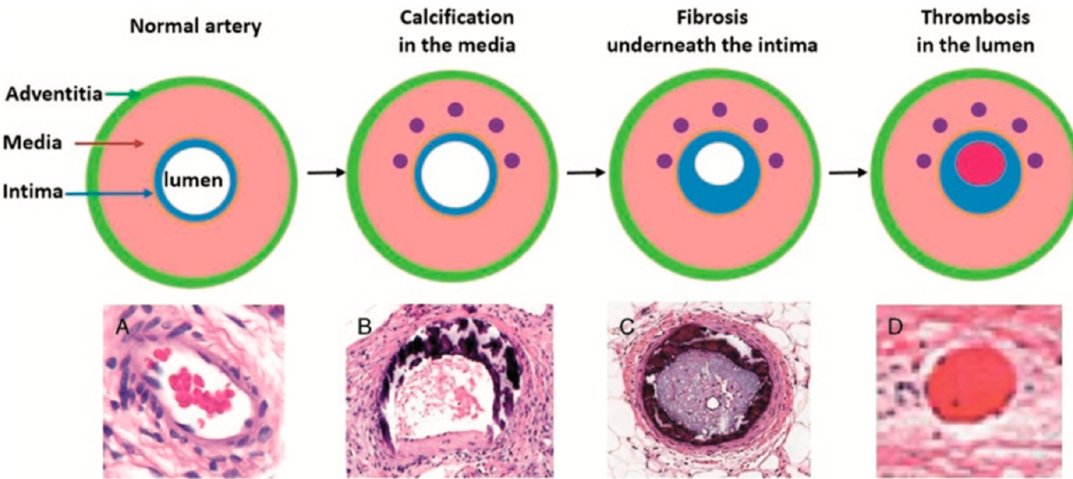
Figure 4. Histological progression of calcification. Initially, the calcification occurs in the media of the arteries due to the presence of uncarboxylated MGP alongside other factors such as apoptotic bodies, calcium ions, phosphate ions and matrix vesicles. Together, these form the initial subendothelial deposition, which contains hydroxyapatite crystals that then continue to mineralise and occlude the lumen of the vessel. Lipids can then deposit on top of the calcified surface of the atherosclerotic plaque continuing to grow into the lumen. This entire deposition can then break off and form a thrombus, which can lead to strokes, myocardial infarction and other cardiovascular disease [21]. Arterial vessels contain 3 layers: the adventia, media and intima enclosing the lumen. Initially there is no calcification in these vessels ( A ). Over time calcium deposits accumulate in the media; this is common in many people and unlikely to cause pathology ( B ). As further calcium accumulates, new deposits develop underneath the intima, causing obstruc-tion of blood flow ( C ). Obstruction can cause turbulent blood flow and a hypercoagulable state, leading to thrombosis within the lumen ( D